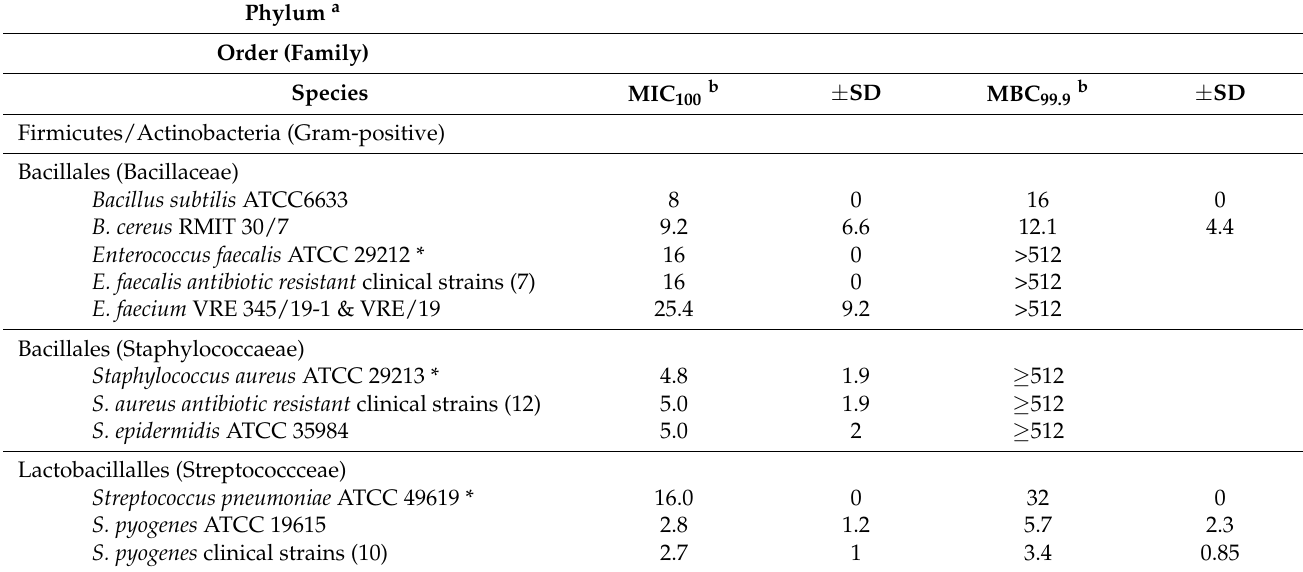
Table 1. Antibacterial activity of NPBD against clinically significant